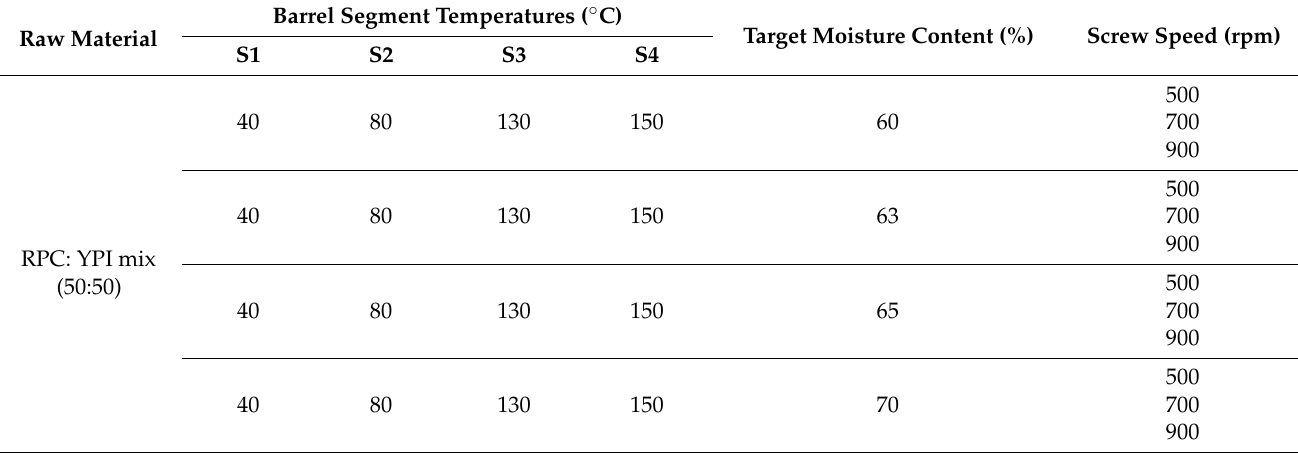
Table A1. Selected processing variables used for extrusion of the mixed